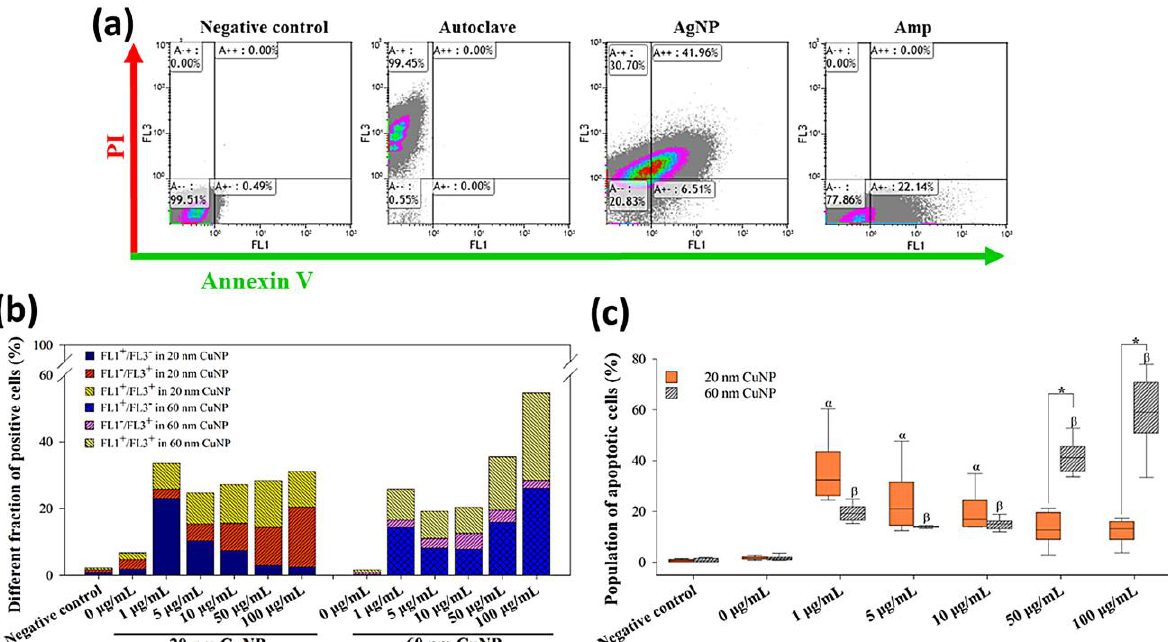
Figure 6. Flow cytometry analysis of annexin V-PI staining in E. coli after CuNP treatment. ( a ) E. coli was treated with PBS (negative control), autoclaving, 10 µ g/mL AgNPs, and 5 µ g/mL Amp, followed by annexin V-PI staining. FL1 and FL3 were regarded as annexin V and PI signals. ( b ) Different fractions of positive cells from quadrants. Bacteria were treated with two sizes of CuNPs in different concentrations for 24 h. Bacteria treated with PBS served as the negative control. Fluorescent intensity was acquired by flow cytometry, and single positive (FL1 + /FL3 − ; FL1 − /FL3 + ) as well as double positive (FL1 + /FL3 + ) signals were calculated. ( c ) Statistical analysis of apoptosis bacterial cells which were represented by the sum of percentages from FL1 + /FL3 − (early stage) and FL1 + /FL3 + (late stage). Data were presented as mean ± SD from six independent experiments performed in triplicate for each treatment group. Data were analyzed by the Kruskal–Wallis H test followed by Dunn’s post hoc test; α and β indicate p < 0.05 for 20 and 60 nm CuNP treatments relative to the negative control, respectively. Statistical difference between 20 and 60 nm CuNP treatments was set at p < 0.05 (*) according to the paired t